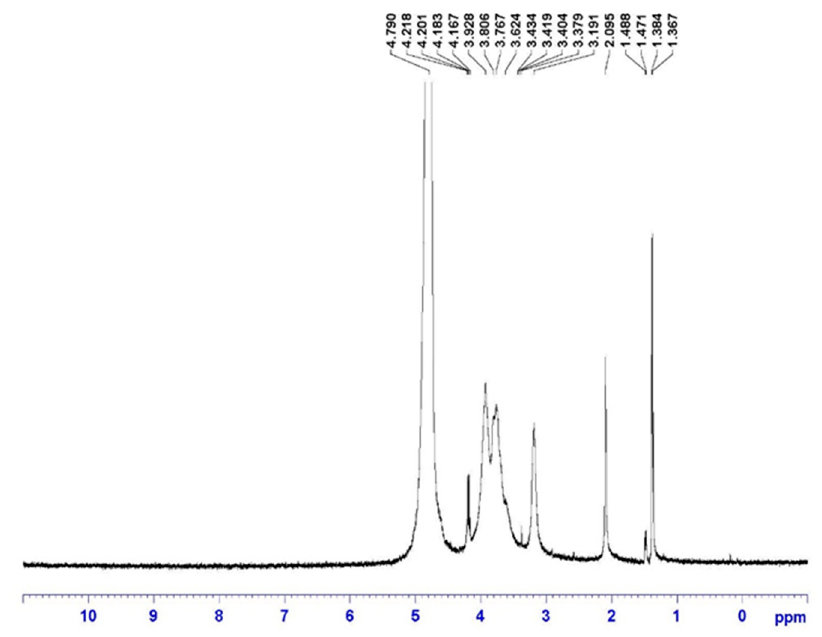
Figure 11. Proton NMR spectrum of chitosan in D 2 O.